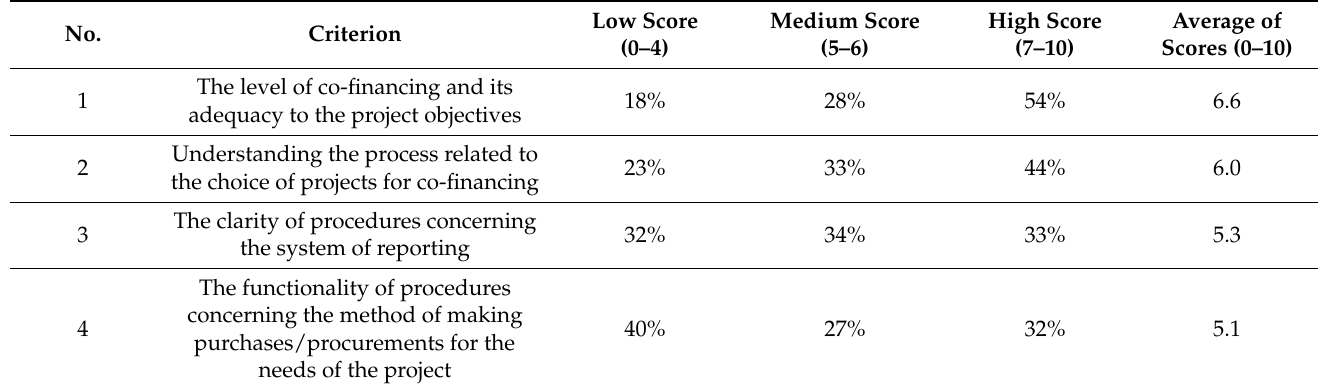
Table 5. The evaluation of the process, procedures, and the value of co-financing within the SMOP program in the scale (0–10).